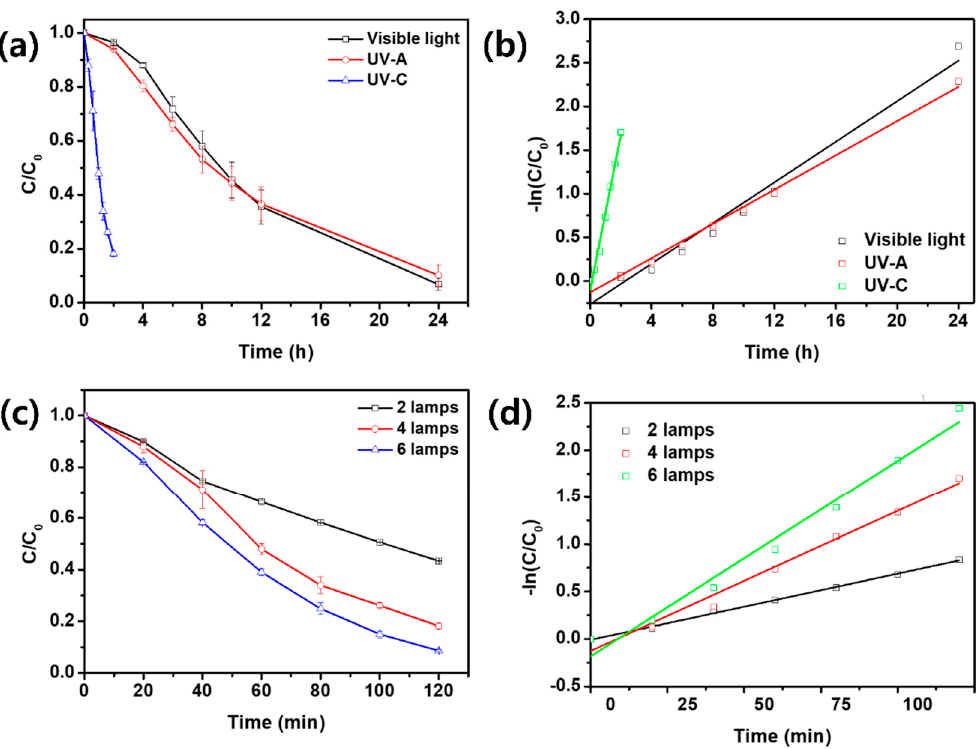
Figure 1. ( a ) Degradation efficiency and ( b ) pseudo-first-order kinetic plots of OTC under different light irradiation sources. ( c ) Effects of light intensity on the OTC degradation efficiency and ( d ) its pseudo-first-order kinetic plots.